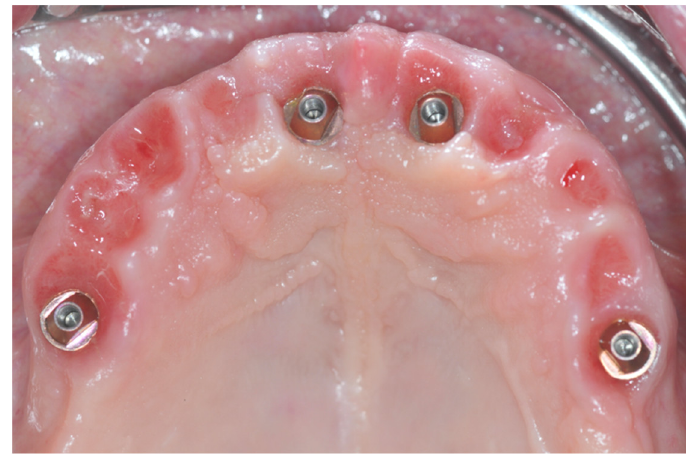
Figure 8. Soft tissue occlusal view after 6 months of provisional conditioning.